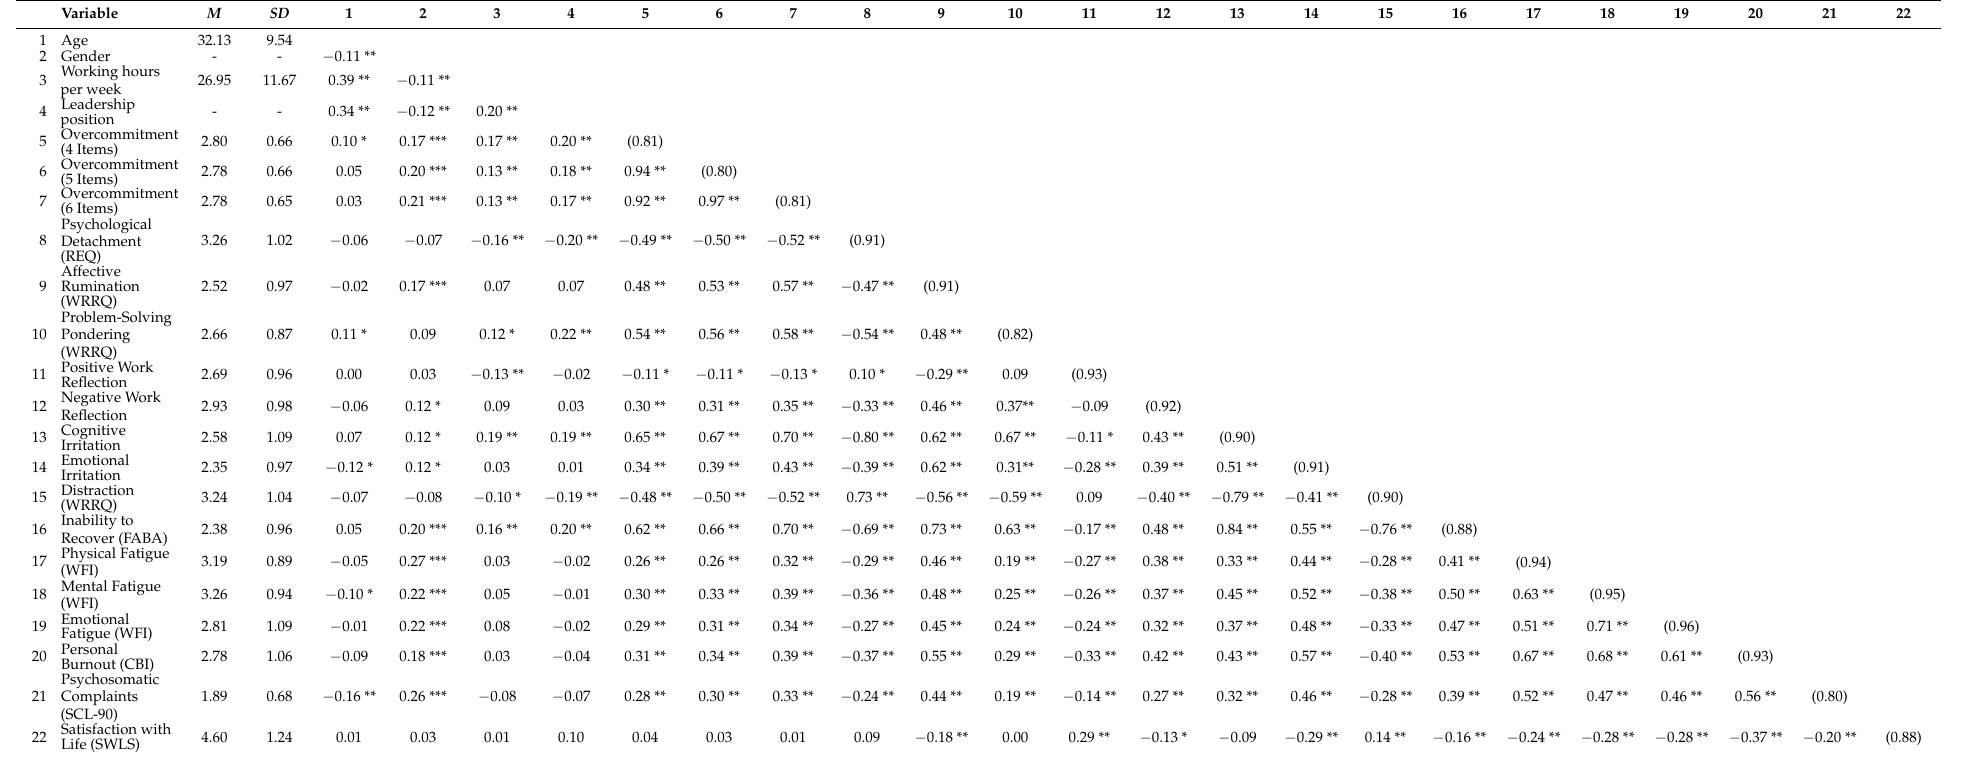
Table 4. Means, Standard Deviations, and Zero-order Correlations among Study